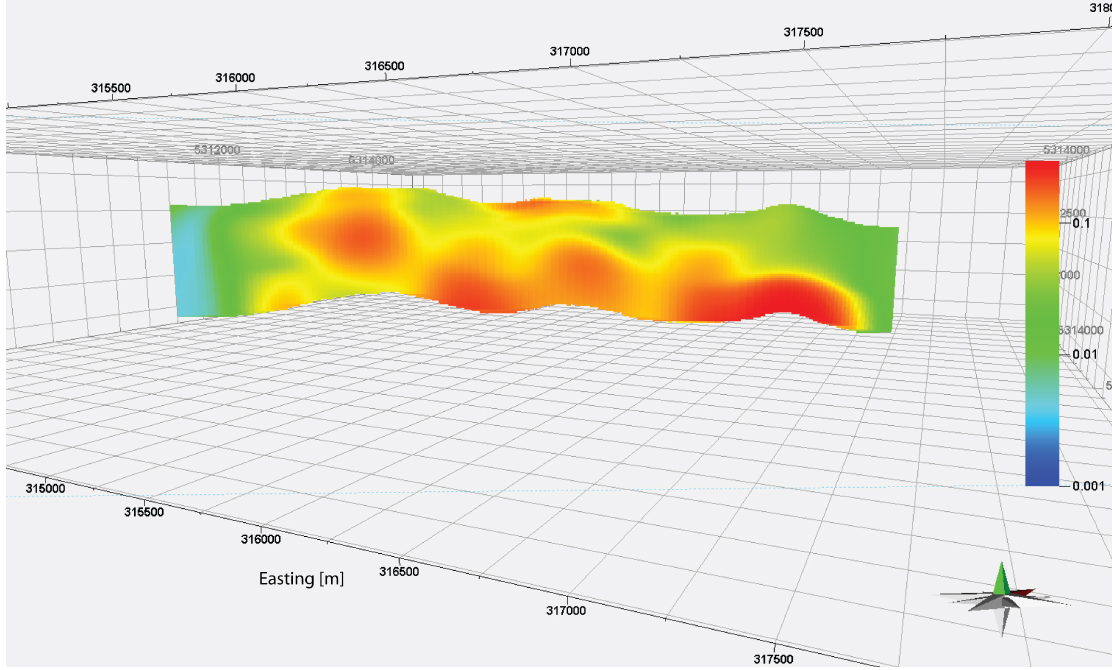
Figure 13. A vertical cross section of the 3D chargeability model recovered from 3D inversion of the pole–dipole IP data along Line